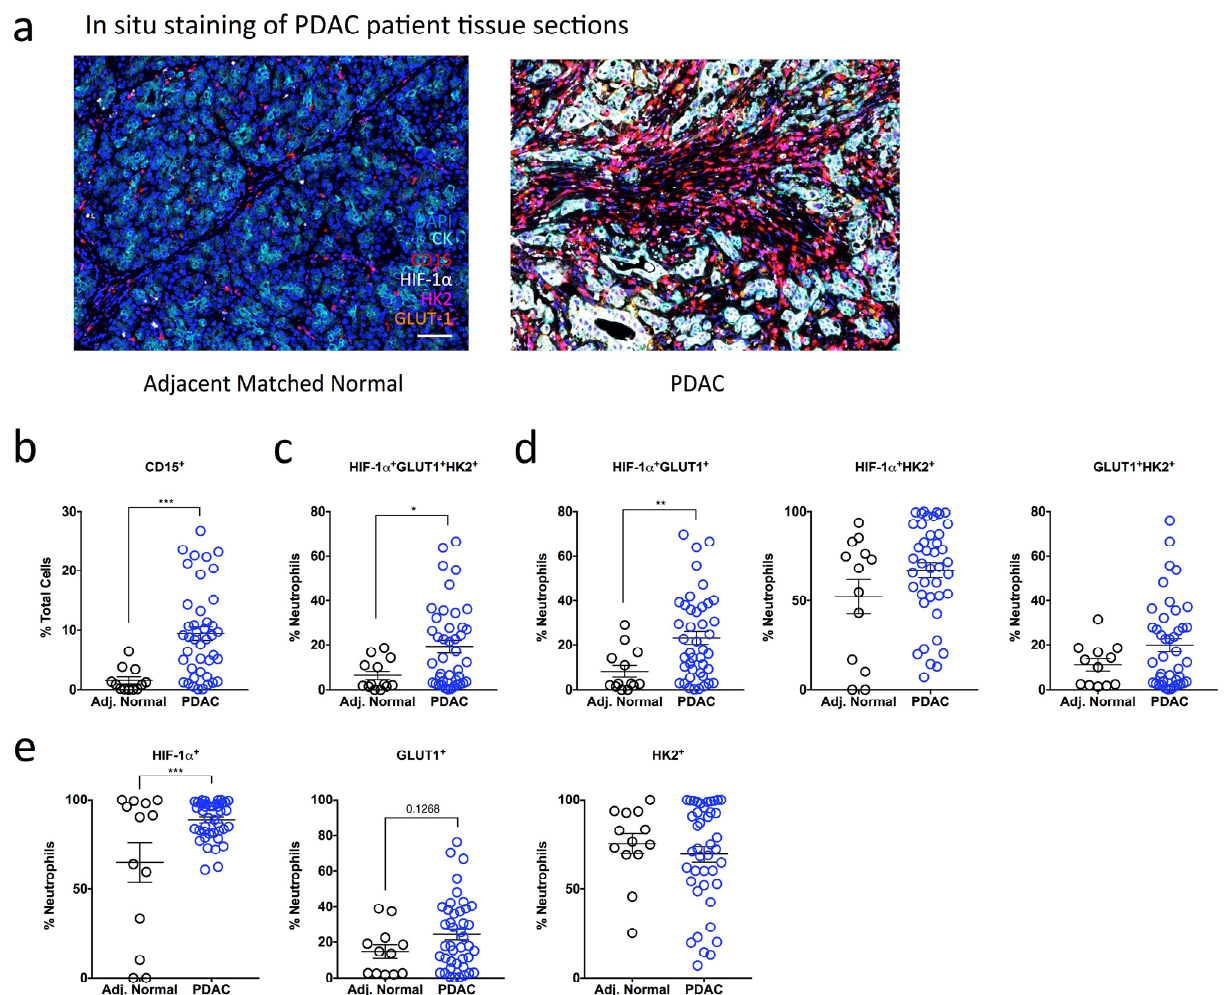
Figure 3. High influx of tumor-infiltrating neutrophils expressing HIF-1 α and glycolytic markers in PDAC patients ( a ) A sequential, multiplex, immunofluorescence staining panel consisting of a neutrophil marker (CD15), pancreatic epithelial cell marker (CK), and metabolic markers (HIF-1 α , GLUT1 and HK2) was used to stain formalin-fixed paraffin-embedded pancreatic sections obtained from multi-center patient cohorts. Images are representative of matched normal adjacent tissue ( n = 13) and PDAC patient tumor tissue ( n = 42). Dapi (blue), CK (cyan), CD15 (red), HIF-1 α (white), HK2 (magenta), GLUT1 (orange). Scale bar = 100 µM. ( b ) Scatter plot showing the total influx of neutrophils in PDAC patient sections (blue clear) compared to matched normal controls (black clear) as a % of total Dapi+ cells. ( c – e ) The expression of multiple metabolic markers was quantified using Inform Software and assessed in PDAC patient tissue compared to adjacent matched normal control tissue. ( c ) Scatter plots represent the expression of triple positive HIF-1 α + GLUT1 + HK2+ subset as a percentage of total CD15+ neutrophils. ( d ) Scatter plots indicate the proportions of double positive HIF-1 α + GLUT1+, HIF-1 α + HK2+ and GLUT1 + HK2+ neutrophils. ( e ) Scatter plots indicate the proportions of HIF-1 α +, GLUT1+ and HK2+ cells as a percentage of total CD15+ neutrophils. Data represent the means ± SEM, * p < 0.05; ** p < 0.01; *** p < 0.001 by unpaired Student’s t -test with a 95% confidence interval.